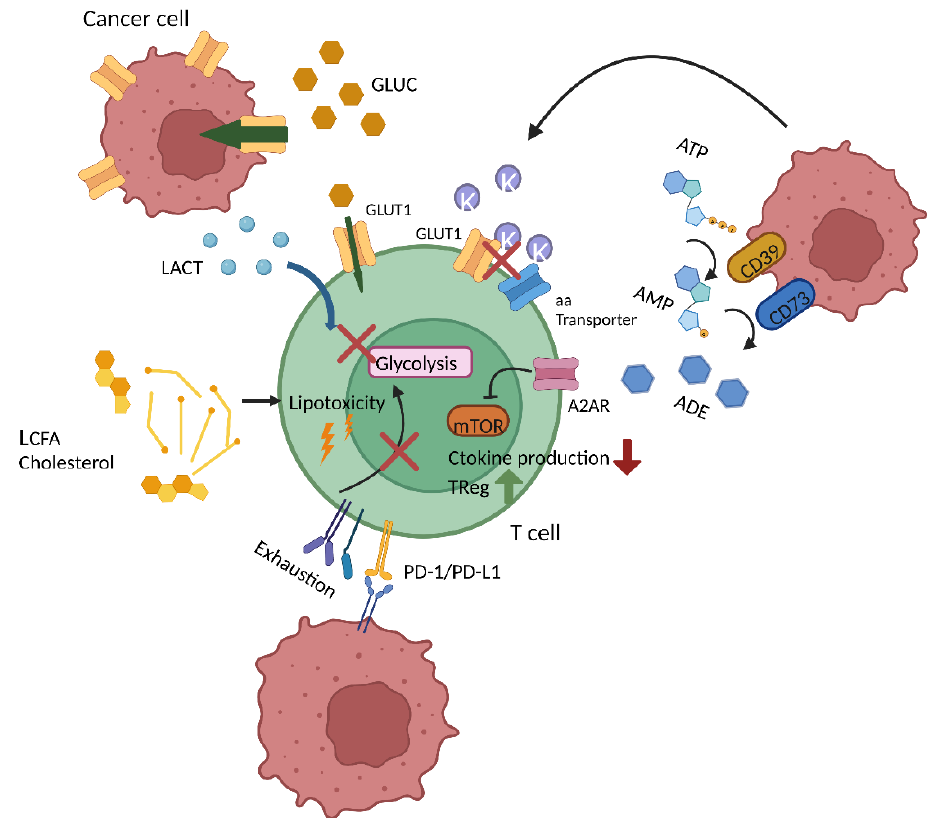
Figure 3. Metabolic barriers for T cells in the TME. The metabolic fitness of T cells can be compro- mised in a variety of ways within the TME. Critical nutrients such as glucose (GLUC) are depleted. Bioenergetically active tumors secrete bioactive molecules such as lactic acid (LACT), which impedes glycolysis. Dying cancer cells release vast amounts of potassium (K) that limits glucose and amino acid uptake. The two ectonucleotidases CD39/CD73 degrade ATP into adenosine (ADE), which also impairs metabolic T cell fitness. Increased levels of lipids together with an increased fatty acid uptake of TME-infiltrating T cells promotes exhaustion and lipotoxicity.